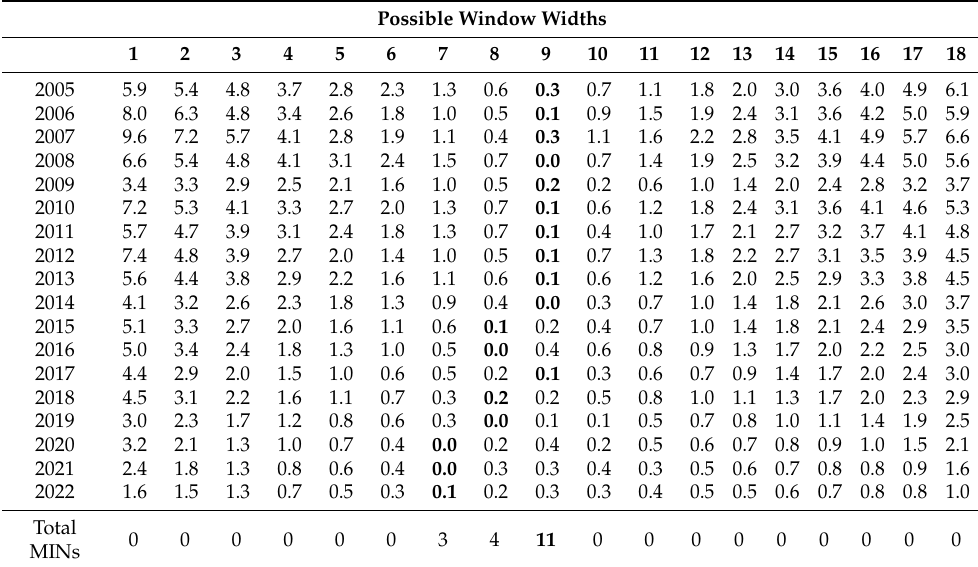
Table 5. Equation (2) results (absolute values) for all possible window lengths for the reference period 2005–2022.